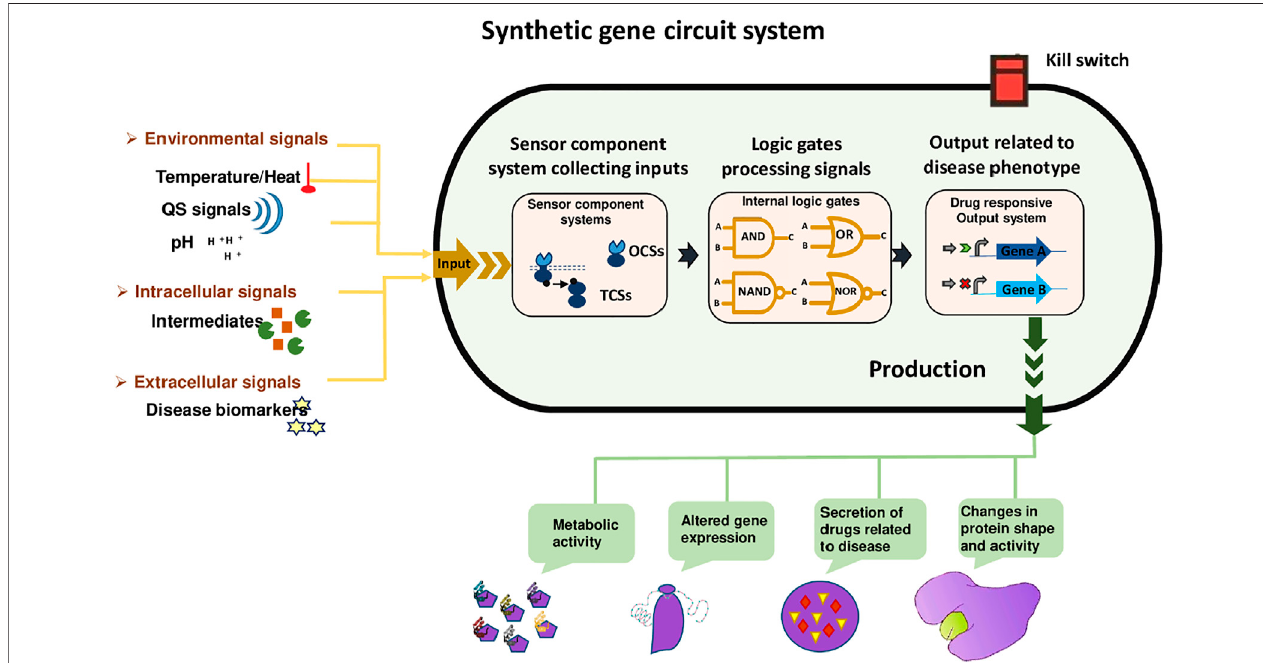
FIGURE 2 | Synthetic gene Circuit System. It has three sections, including a sensing unit that can sense environmental signals (temperature, heat, and pH), intracellularsignals(intermediates),andextracellularsignals(diseasebiomarkers).Thesesignalsarereceivedbythesignalprocessingunitthatprocessesthesignalswith the combination of logic gates to actively sense target stimuli. Moreover, AND, NAND, OR, and NOR are complex logic gates employed for multilayered logical processing.Finally,theactuatordictatestheoutputofsystemparameters,forexample,themodulationofgeneexpressionandenzymeproteolysisultimatelyhikes desiredbiologicalfunctionsandphenotypes,suchascellgrowthregulation,cellmorphology,fate,andmotilitychange.Killswitchesareusuallyusedindesignedbacteria so that their population can be controlled after accomplishing their